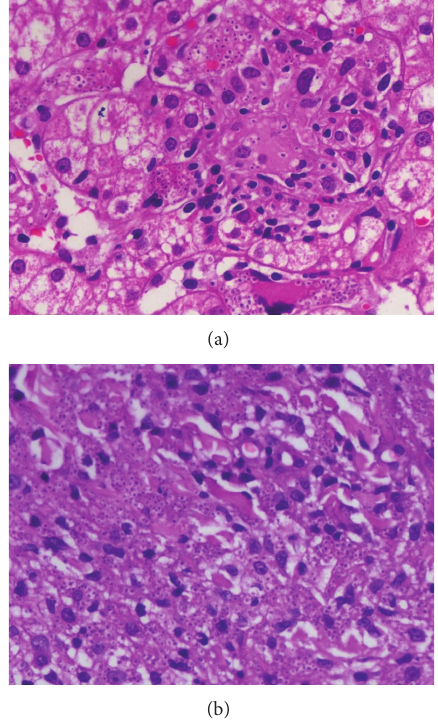
Figure 2: Histopathological examination of the liver (a) and skin lesion (b) showing features of LD bodies in the former and amastigote forms in the latter. H&E stain (400x) and eosin stain (400x), respectively.